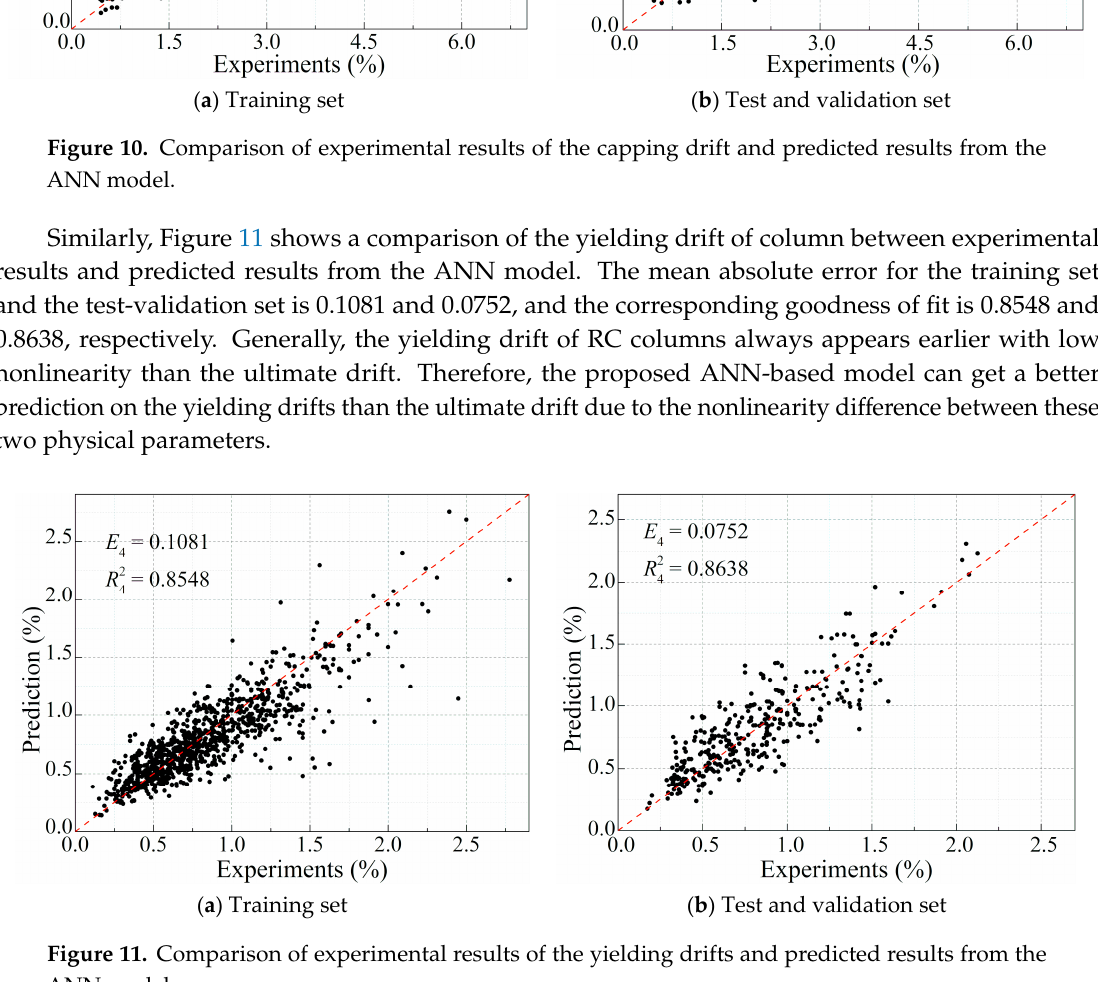
Figure 10. Comparison of experimental results of the capping drift and predicted results from the ANN model.